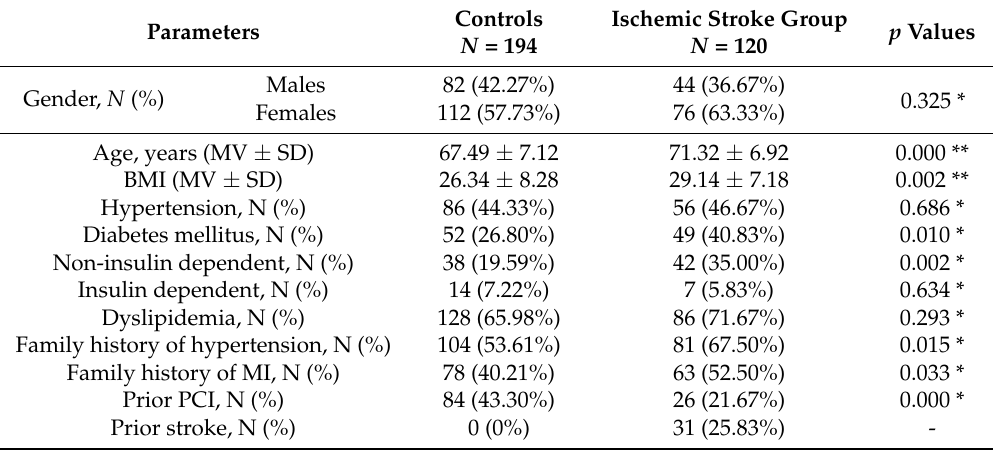
Table 1. Demographic and clinical parameters of studied